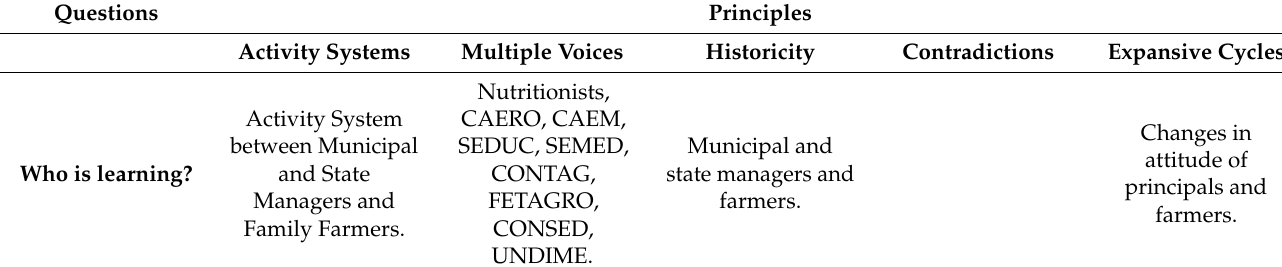
Table 2. CHAT guiding questions in the municipality of Porto